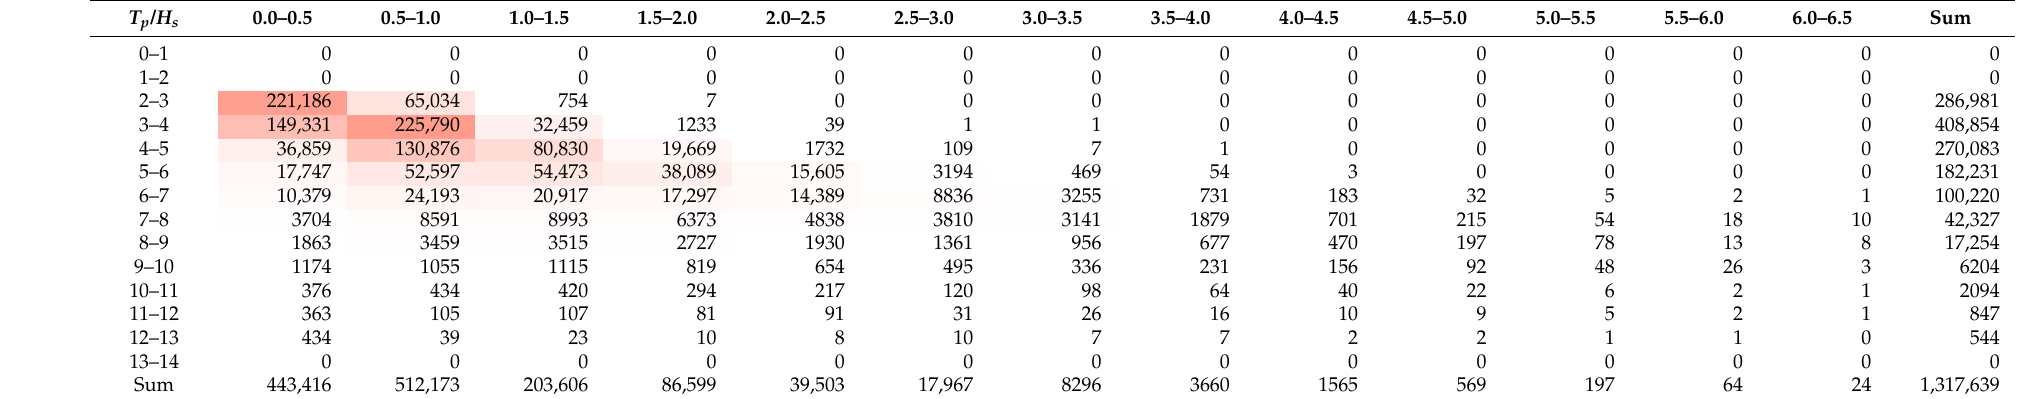
Table 1. Sea state table–entire Adriatic Sea basin, period September 1992–January 2016.